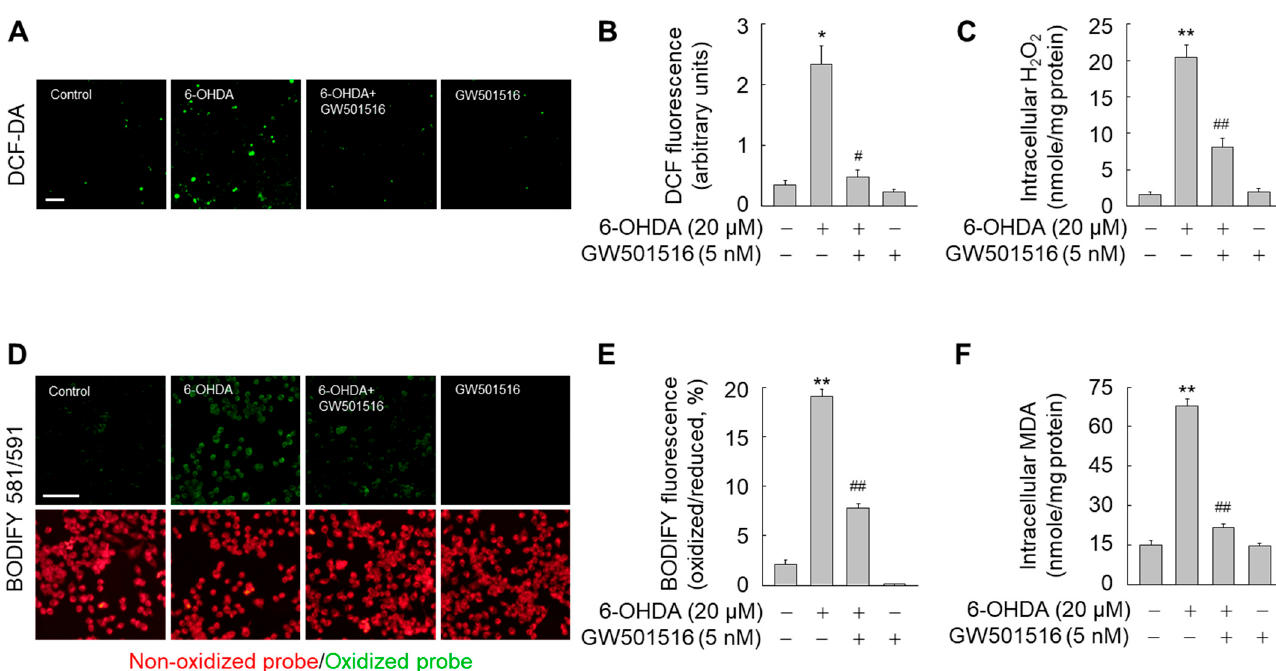
Figure 7. GW501516 PPAR δ activation suppresses 6-OHDA-triggered accumulation of ROS and lipid peroxides. ( A – C ) Cells pretreated with DMSO or GW501516 for 8 h were incubated with or without 6-ODHA for 24 h. Intracellular ROS levels were determined using DCF-DA dye under fluorescence microscopy ( A ) and the fluorescence was quantitated using cells treated with DMSO as control ( B ). The levels of hydrogen peroxide were detected using Amplex™ Red hydrogen peroxide assay kit ( C ). ( D – F ) In parallel experiments, lipid peroxides were determined using C11-BODIPY 581/591 under fluorescence microscopy ( D ) and BOFIFY fluorescence was quantitated using cells treated with DMSO as control ( E ). Intracellular malondialdehyde (MDA) levels were determined using EZ-lipid peroxidation (TBARS) assay kit ( F ). Results are expressed as means ± SE ( n = 3). Scale bar, 100 μ m. * p < 0.05, ** p < 0.01 relative to untreated group; # p < 0.05, ## p < 0.01 relative to 6-OHDA- treated group.